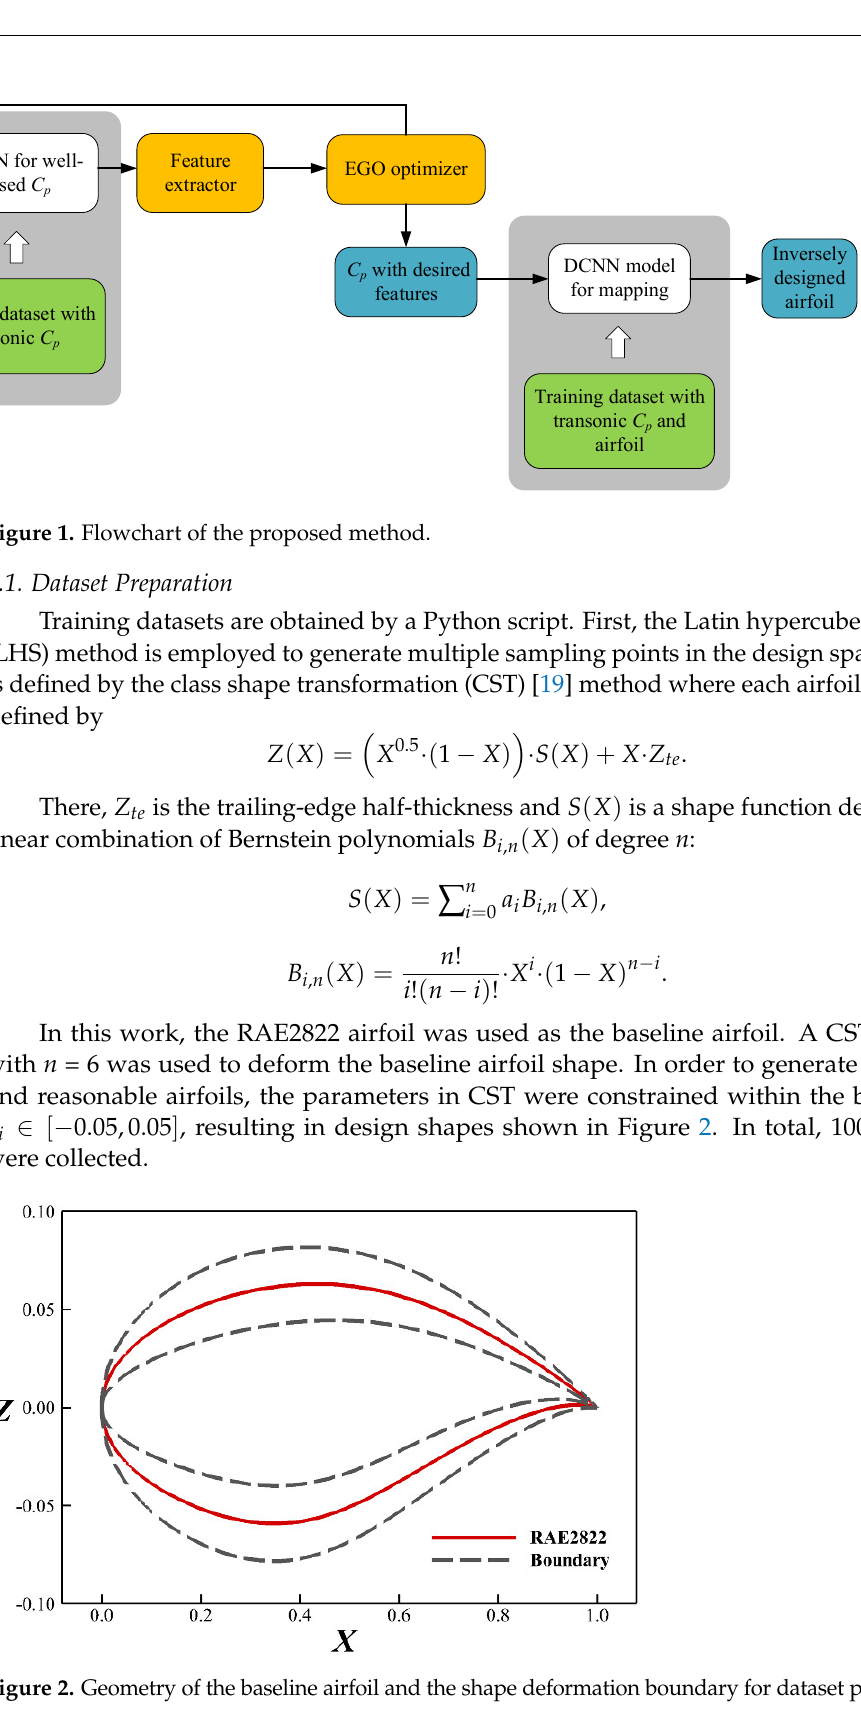
Figure 3. Pressure distribution of CFD simulation and the experiment for RAE2822 baseline. 2.2. WGAN for Well-Posed Pressure Distributions GAN adopts two adversarial models to learn from the training data. A generative model G is used to capture the real data distribution P real and a discriminative model D is used to estimate the probability that a sample comes from the real data rather than from G . Models G and D are trained simultaneously to reach a Nash equilibrium, which is the optimal point for the loss function L in a two-player minimax game defined as min  max   (, ) =  ~  [()] +  ~   1 − ()